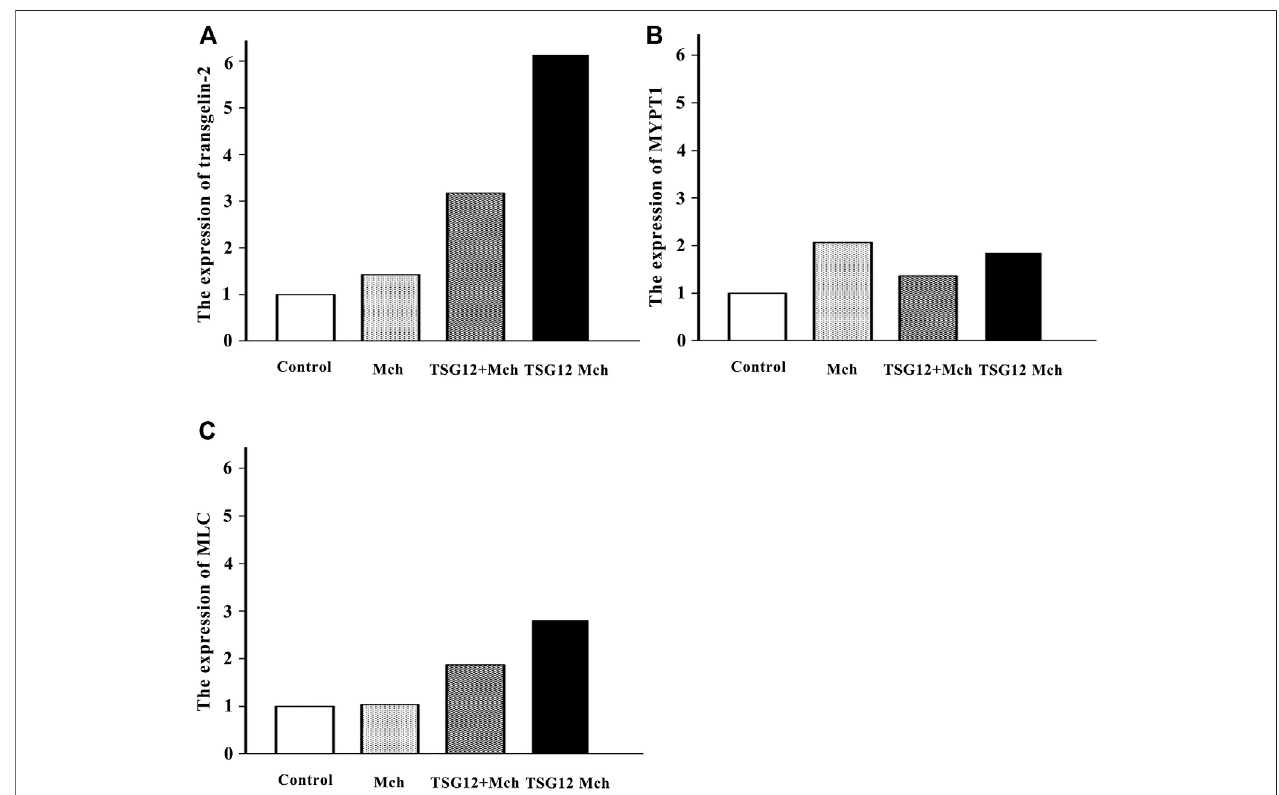
FIGURE4| Expressionofrelevantgenesafter TSG12administration. (A) Expressionlevelsoftransgelin-2wereup-regulatedby1.4-,3.2-, and6.1-foldintheMch group, TSG12 + Mch group, and TSG12 Mch group, respectively (vs. blank). (B) Expression levels of MYPT1 were up-regulated by 2.1-, 1.4-, and 1.9-fold in the Mch group, TSG12 + Mch group, and TSG12 Mch group, respectively (vs. blank). (C) Expression levels of MLC were up-regulated by 1.1-, 1.9-, and 2.8-fold in the Mch group,TSG12+Mchgroup,andTSG12Mchgroup,respectively(vs.blank).Valueswerepresentedbythe2 − ΔΔ Ct method,N=6,changeswitha2-foldincreasein expression were considered to be up-regulated, and changes with a 0.5-fold decrease in expression were considered to be down-regulated. Abbreviations: Mch, methacholine; MYPT1, myosin phosphatase target subunit-1; MLC, myosin light chain.